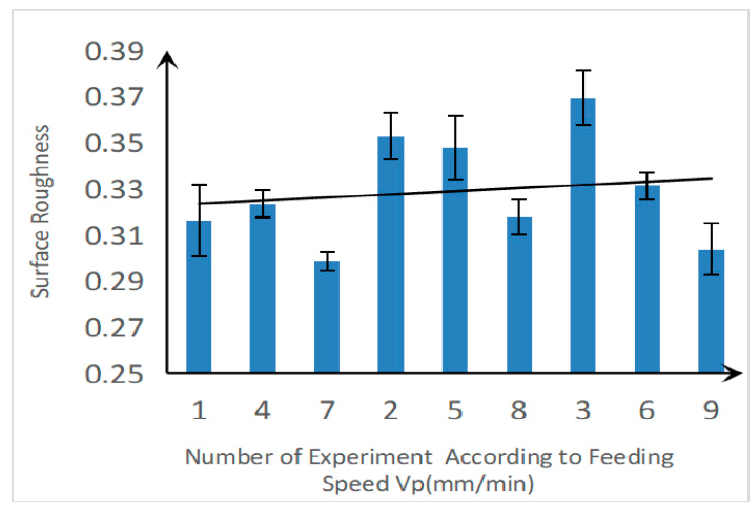
Figure 10. Relationship between the surface roughness and the feed rate of the grinding head.